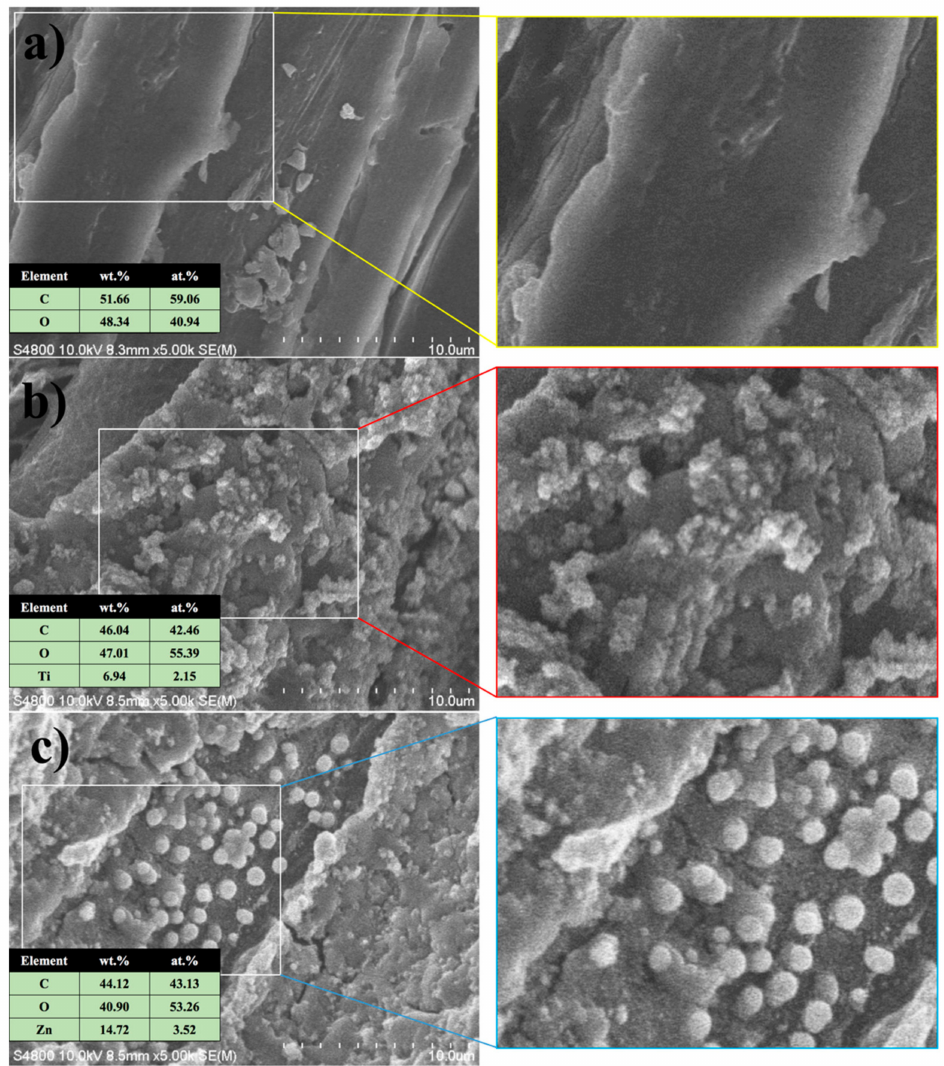
Figure 4. Scanning electron microscopy images of Larix spp. wood samples before and after surface modification: ( a ) Control; ( b ) TiO 2 modified wood; ( c ) ZnO modified